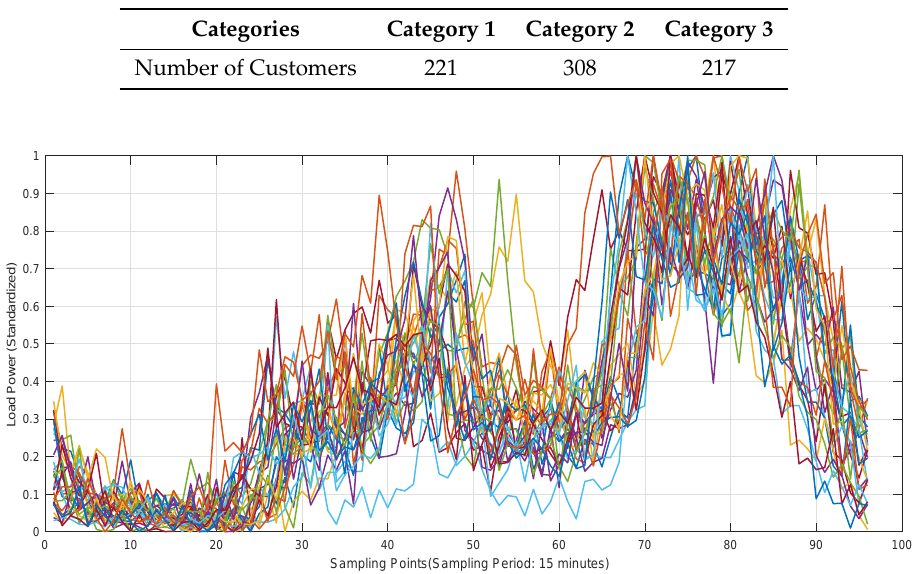
Figure 6. Load curves of 30 customers in Category